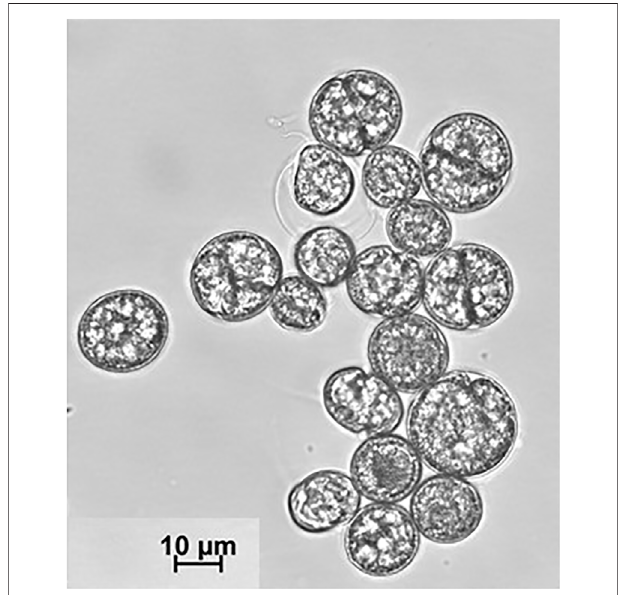
FIGURE 1 | Cutout from an optical micrograph of C. cohnii cell suspension taken on day 4 of